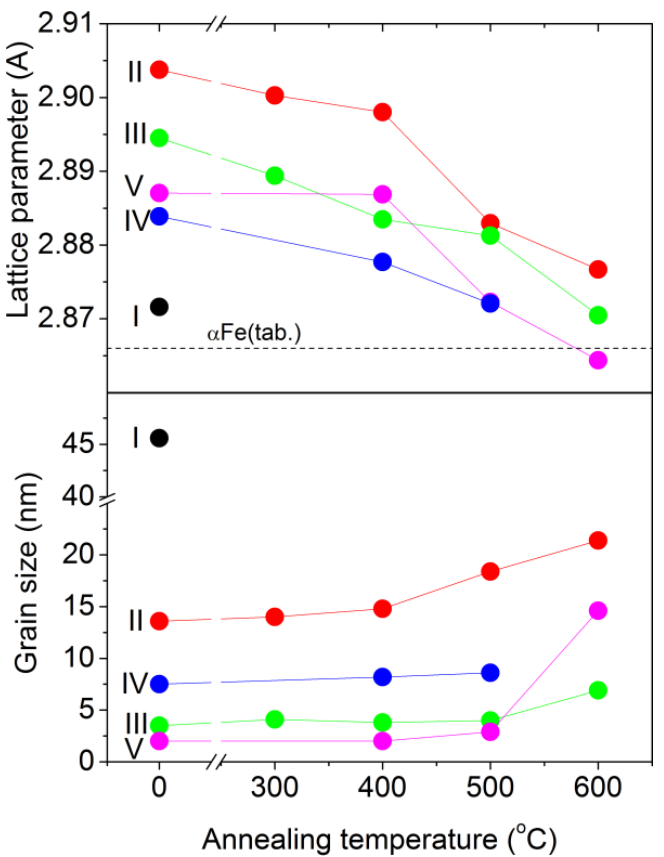
Figure 6. The influence of the annealing temperature on the lattice parameter and the grain size of the bcc phase.